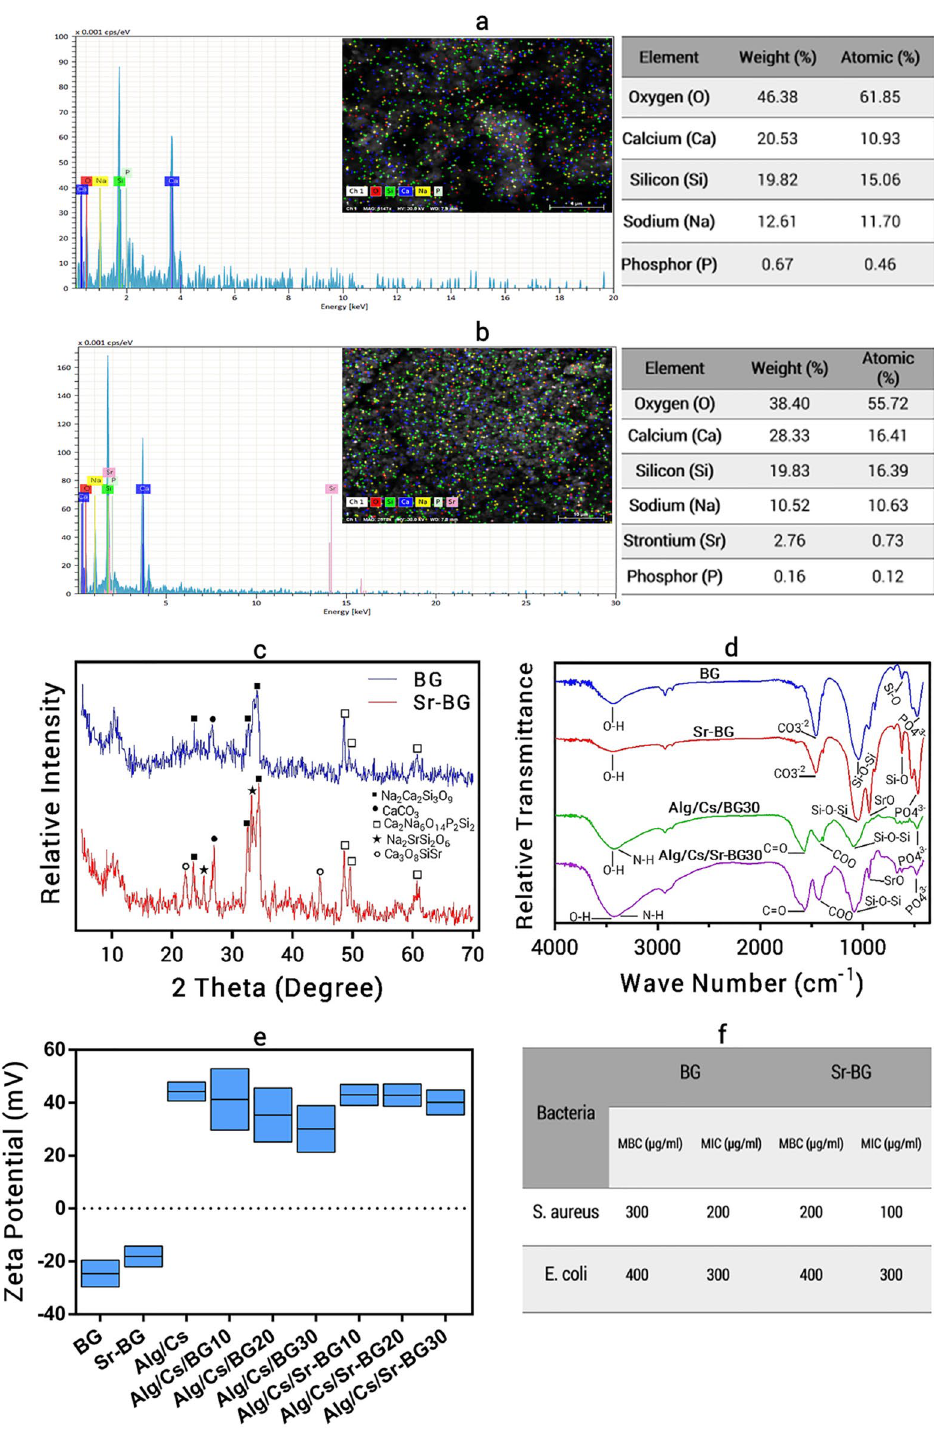
Figure 2. EDS profile and XRD pattern of bopglasses, FTIR spectra and zeta potential of bioglasses/scaffolds and antimicrobial activity of bioglasses. ( a ) BG EDS profile, ( b ) Sr-BG EDS profile, ( c ) XRD pattern of BG and Sr-BG, ( d ) FTIR spectra of BG, Sr-BG, Alg/Cs/BG30 and Alg/Cs/Sr-BG30, ( e ) Zeta potential of bioglasses/ scaffolds, ( f ) Antimicrobial activity of